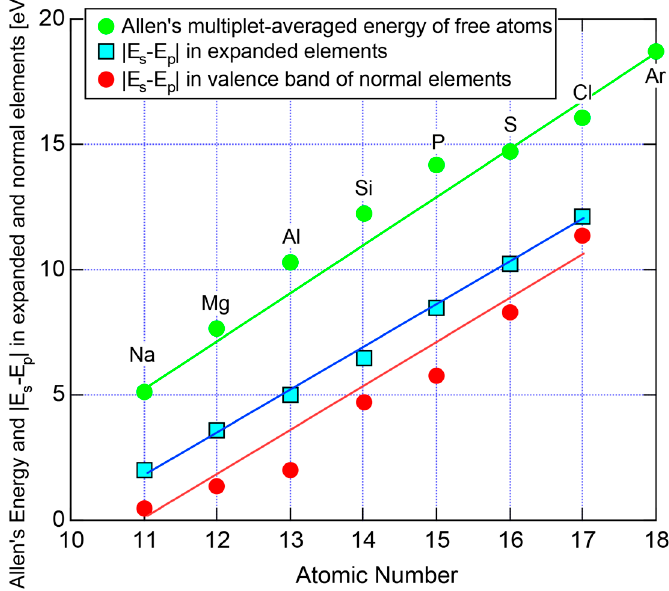
Figure 27. Allen’s multiplet-averaged energy ( ● ) of free atoms in comparison with E expanded elements with a = 2 a 0 ( ) and that of elements with a = a 0 ( ● ). a 0 : lattice constant of elements under normal conditions. See Equation (16) for the definition of E A s and E A p for an element